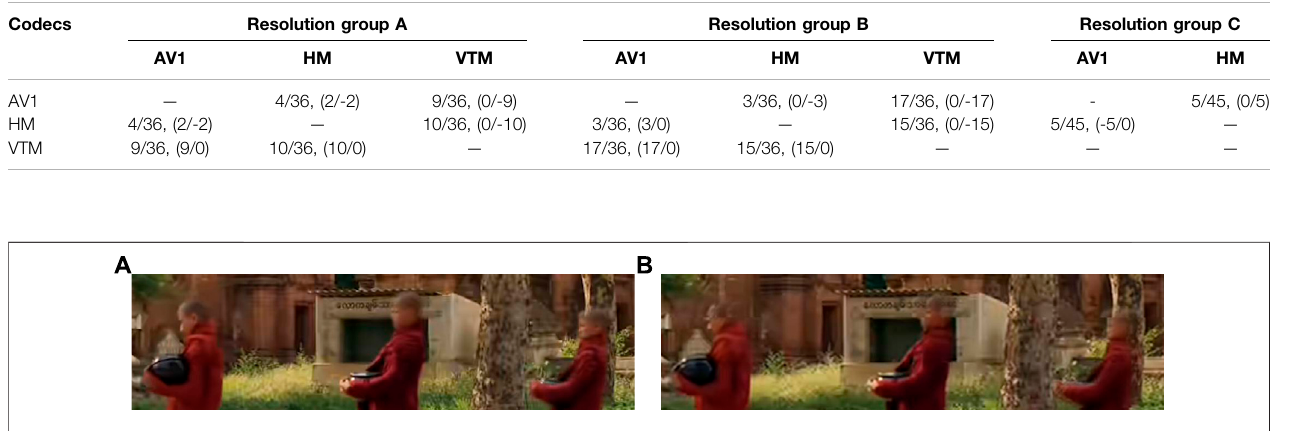
TABLE 6 | Aggregated signi fi cant difference of perceived quality among the tested codecs based on the ANOVA. The fi rst ratio represents the number of sequences where statistically signi fi cant difference has been recorded. The ratio in the parentheses show which codec is signi fi cantly better (+) or worse ( − ) in the pairwise comparison of horizontal/vertical codec.